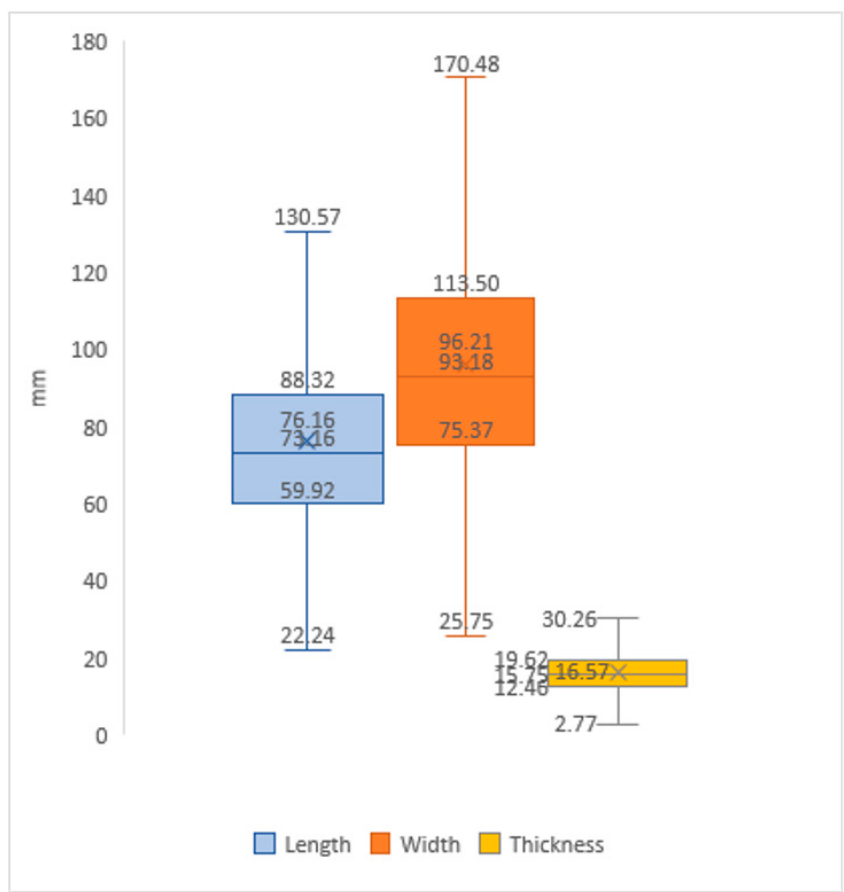
Figure 6. Length, width and thickness of RHBF flakes.